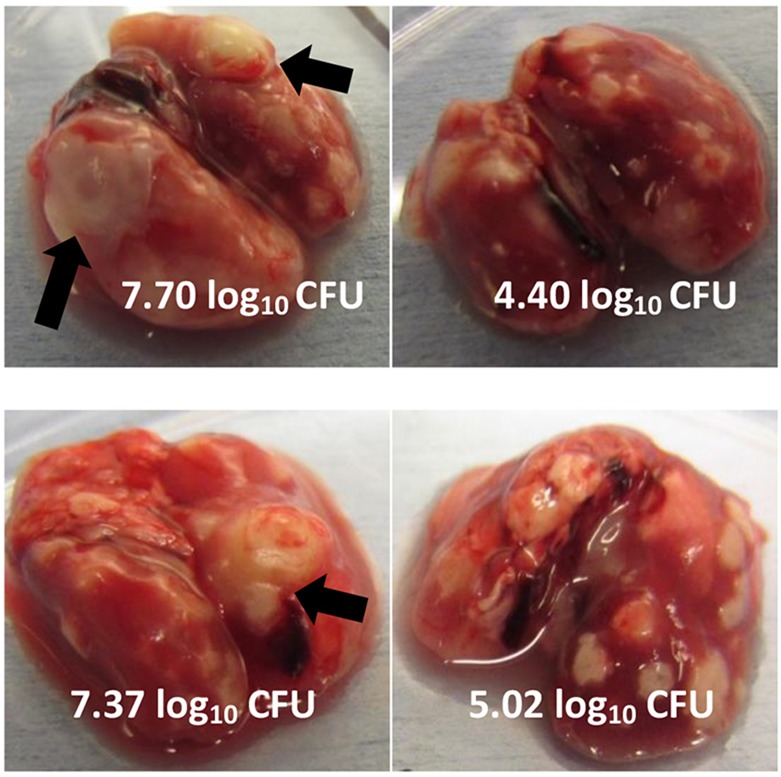
Examples of gross pathology and correlation with lung CFU counts from mice in the 14-week incubation arm following treatment with pyrazinamide or linezolid. PZA, upper panels; LZD, lower panels. Arrows show large, expansile tubercular lesions in the lungs with the highest CFU counts.